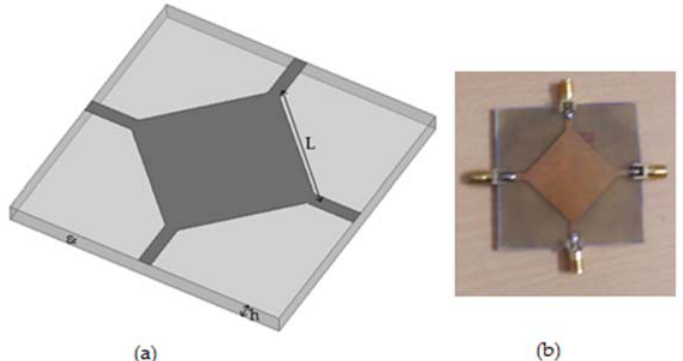
Figure 7. Diamond Patch Crossover (DPC). ( a ) Schematic of DPC; ( b ) Photo of the fabricated prototype.